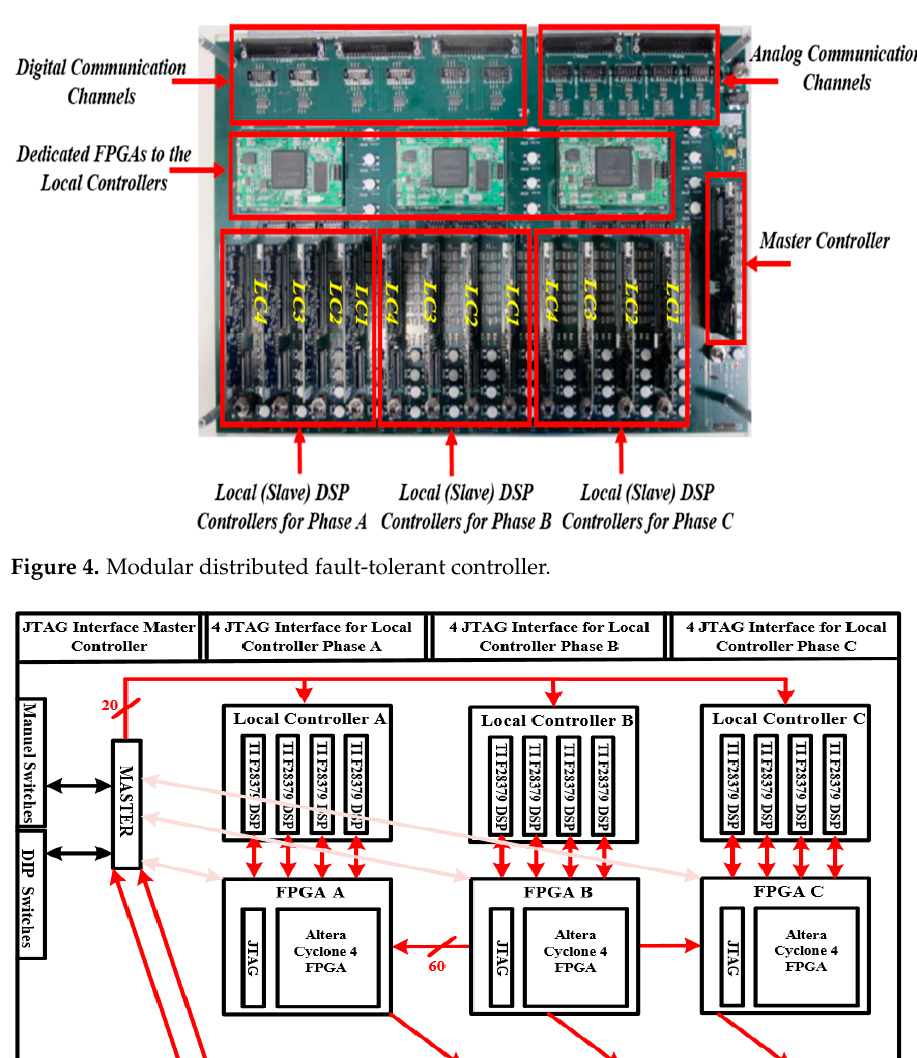
6 of 19 Figure 3. A block diagram of the implemented phase averaging controller.